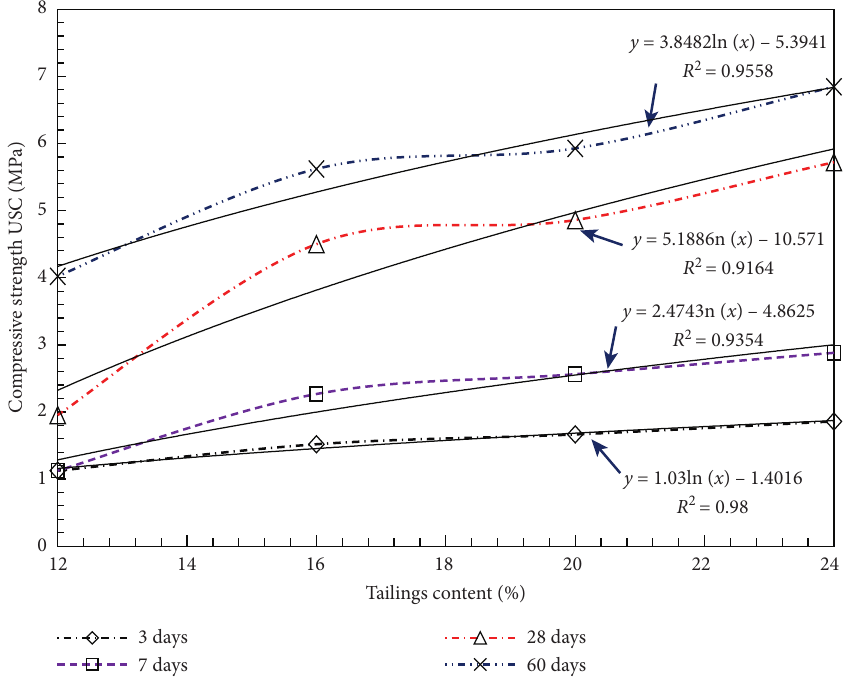
Figure 1: Effect of the tailings content on the strength of